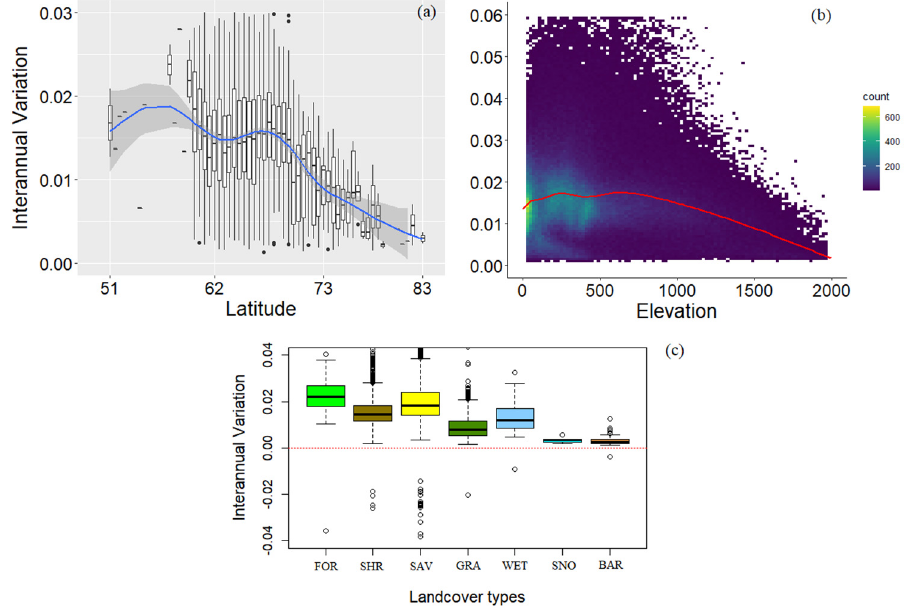
Figure 16. Interannual variation trend of GPP (g C m − 2 year − 1 ) distribution with latitude ( a ), elevation (m) ( b ) over the Arctic. The gray belt refers to the confidence interval of 95%, the blue line refers to the fit line, and the boxplots denote the distribution of the annual-averaged GPP with the latitude. ( c ) Land cover-dependent interannual variation trend of GPP (g C m − 2 year − 1 ) over the Arctic. FOR, SHR, SAV, GRA, WET, SNO, and BAR denote the forests, shrublands, savannas, grasslands, permanent wetlands, permanent snow and ice, barren, and water bodies, respectively.